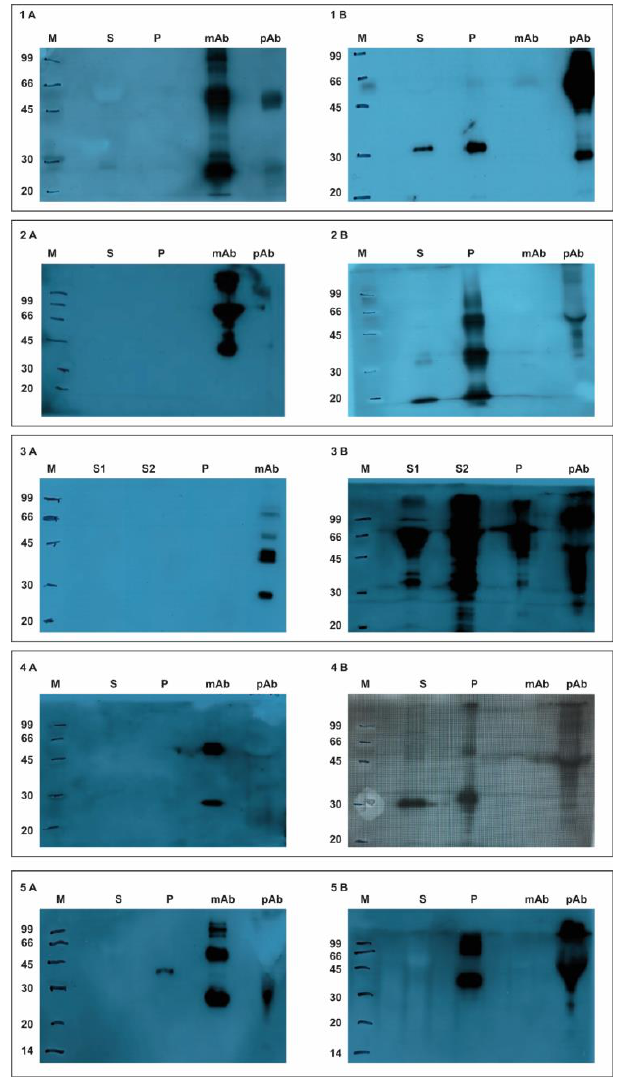
Figure 3. Panel ( 1A ): WB results of the mAb anti-PCV2 against virus sample (line S), recombinant ORF2 capsid protein (line P), and purified mAb and pAb anti-PCV2 (lines mAb and pAb). Panel ( 1B ): WB results of the pAb anti-PCV2 against virus sample (line S), recombinant ORF2 capsid protein (line P), and purified mAb and pAb anti-PCV2 (lines mAb and pAb). Panel ( 2A ): WB results of the mAb anti-PRRSV against virus sample (line S), recombinant NP nucleocapsid protein (line P), and purified mAb and pAb anti-PRRSV (lines mAb and pAb). Panel ( 2B ): WB results of the pAb anti-PRRSV against virus sample (line S), recombinant NP nucleocapsid protein (line P), and purified mAb and pAb anti-PRRSV (lines mAb and pAb). Panel ( 3A ): WB results of the mAb anti-PPV against ST and SK-6 virus samples (lines S1 an S2), recombinant _VP2 protein (line P), and purified mAb and pAb anti-PPV (lines mAb and pAb). Panel ( 3B ): WB results of the pAb anti-PPV against ST and SK-6 virus samples (lines S1 an S2), recombinant VP2 protein (line P), and purified mAb and pAb anti-PPV (lines mAb and pAb). Panel ( 4A ): WB results of the mAb anti-ASFV against virus sample (line S), recombinant p30 capsid protein (line P), and purified mAb and pAb anti-ASFV (lines mAb and pAb). Panel ( 4B ): WB results of the pAb anti-ASFV against virus sample (line S), recombinant p30 capsid protein (line P), and purified mAb and pAb anti-ASFV (lines mAb and pAb). Panel ( 5A ): WB results of the mAb anti-CSFV against virus sample (line S), recombinant E2 envelope protein (line P), and purified mAb and pAb anti-CSFV (lines mAb and pAb). Panel ( 5B ): WB results of the pAb anti-CSFV against virus sample (line S), recombinant E2 envelope protein (line P), and purified mAb and pAb anti-CSFV (lines mAb and pAb).